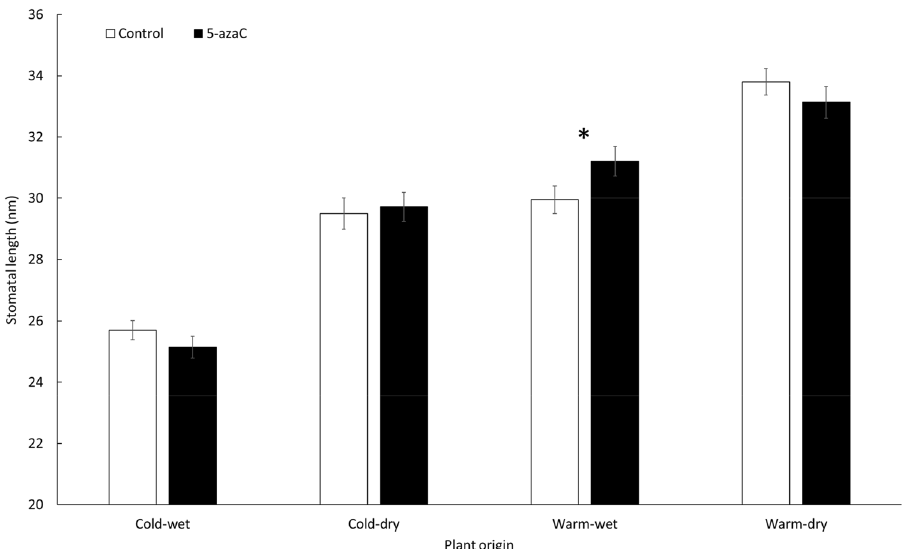
Figure 2. The effect of interaction between original conditions and 5-azaC application on stomatal length. Columns show mean ± SE. Asterix denotes significant difference within pair of columns (p ≤ 0.05). The figure is shown as a box plot in Supplementary Fig. 2. The data were measured at the end of the experiment using 6 replicates of each of 6 genotypes from each of 4 populations of origin grown in 2 growth chambers, all subjected to control and 5-azaC treatments, resulting in 576 experimental plants. The overall test is reported in Table